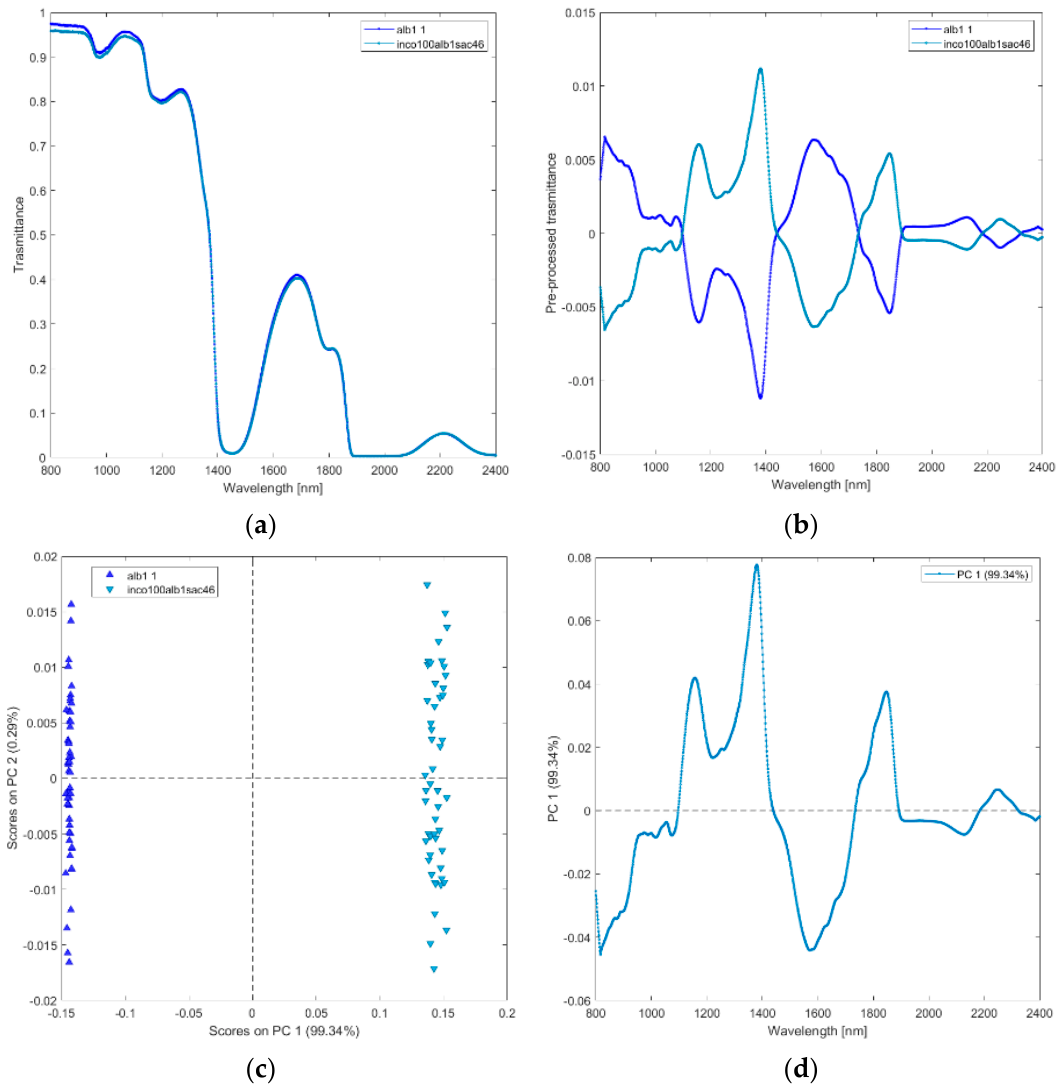
Figure 9. Average raw ( a ) and pre-processed ( b ) transmittance spectra for incobotulinum A toxin (inco100alb1sac46), and HSA (alb1). Scores on PC1 vs. PC2 ( c ) and loading plot of PC1 ( d ) for incobotulinum A toxin (inco100alb1sac46), and HSA (alb1). (ix) Solutions of lactose (lact1), and sucrose (sac46). The raw and pre-processed transmittance spectra of lactose and sucrose are shown in Figure 10a,b. PCA scores plot and loadings plot of the first principal components are shown in Figure 10c,d. PC1 captured 97% of the total variance. As shown in Figure 10c, the scores of lactose are in the negative space of PC 1 due to the wavelength ranges around 1000–1450 nm (mainly corresponding to water region associated with O-H stretching, the second overtone of CH and the first overtone combinations of CH; Figure 10d) and 1550–1850 nm (corresponding to CH, and the first overtone of CH), while the scores of sucrose are clustered in the positive space of PC